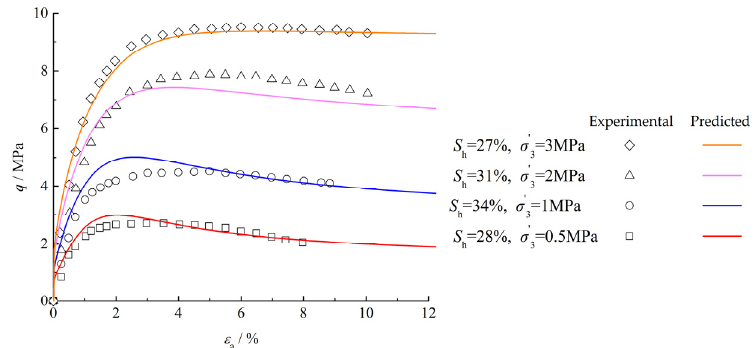
Figure 4. Comparison of the predicted stress–strain curves with the experimental results [24].